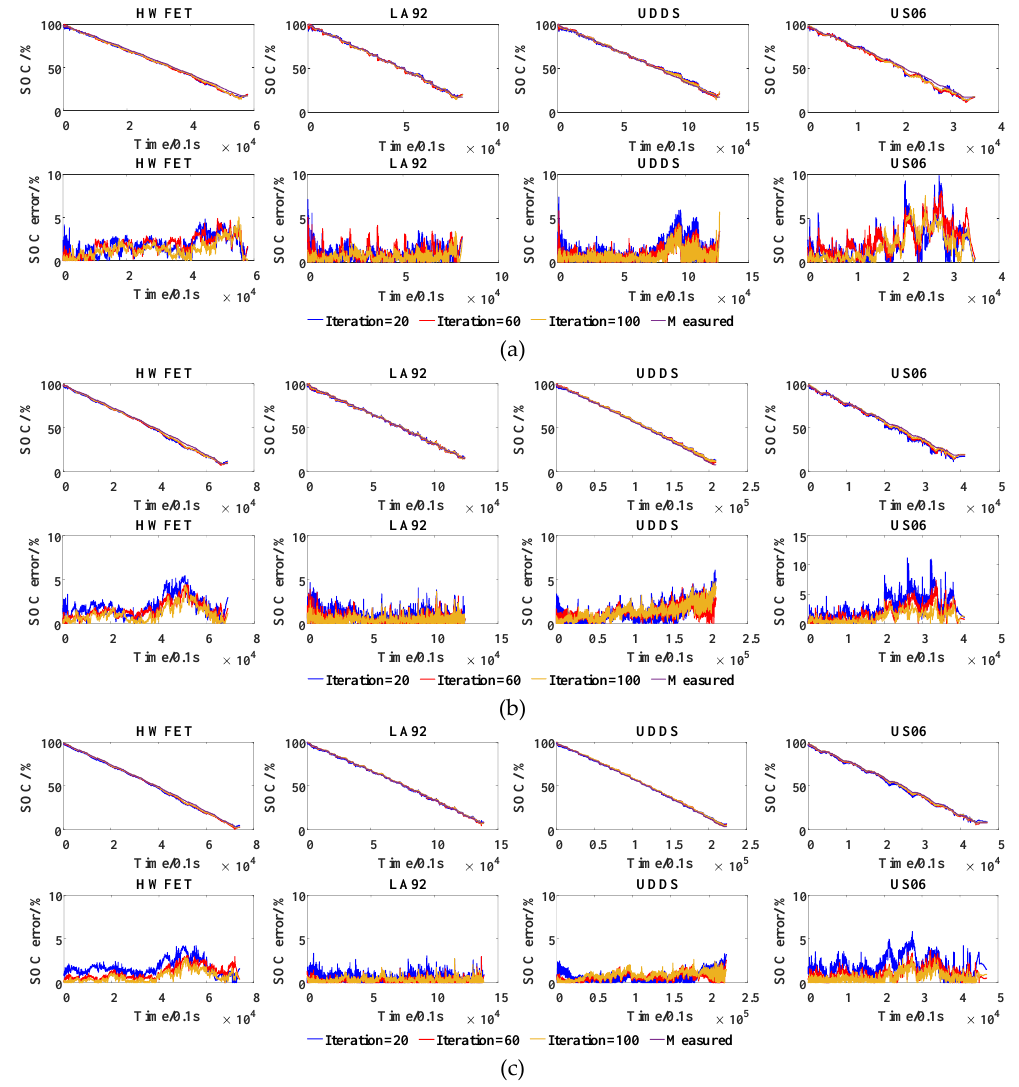
Figure 10. SOC estimation curves with different values of iteration: ( a ) 0 °C; ( b ) 10 °C; ( c ) 25 °C.